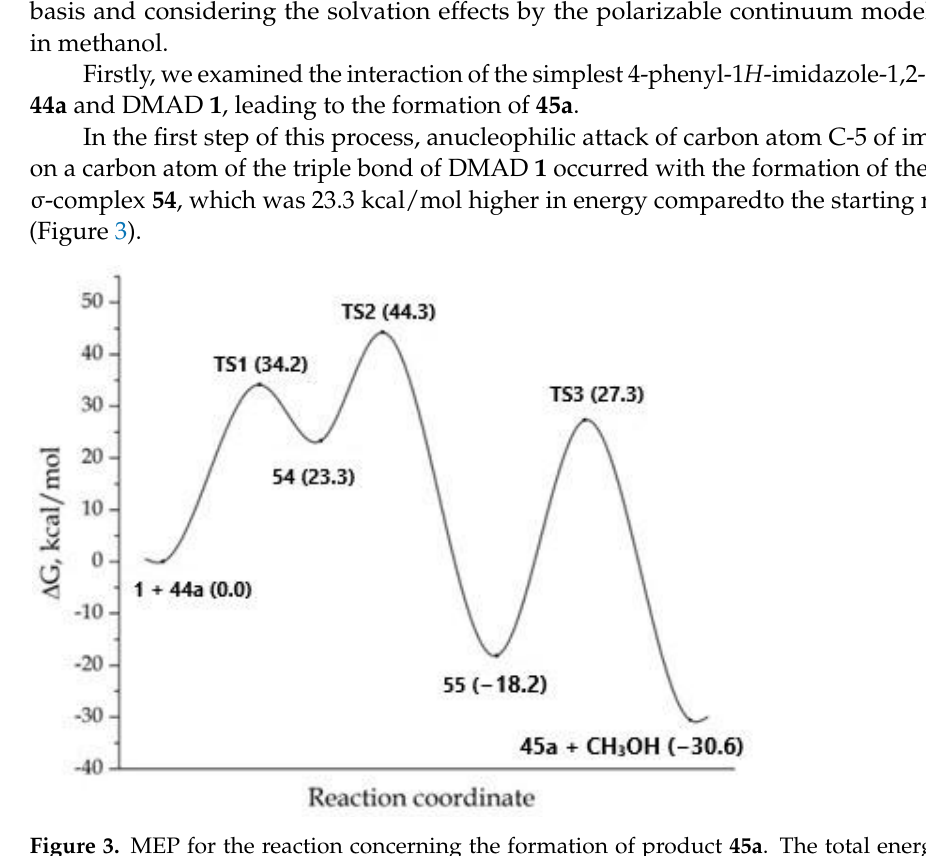
Figure 3. MEP for the reaction concerning the formation of product 45a . The total energy of the starting reagents 1 and 44a was taken as the reference